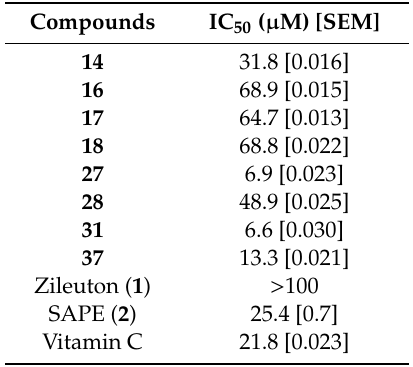
Table 1. Free radical scavenging activity.